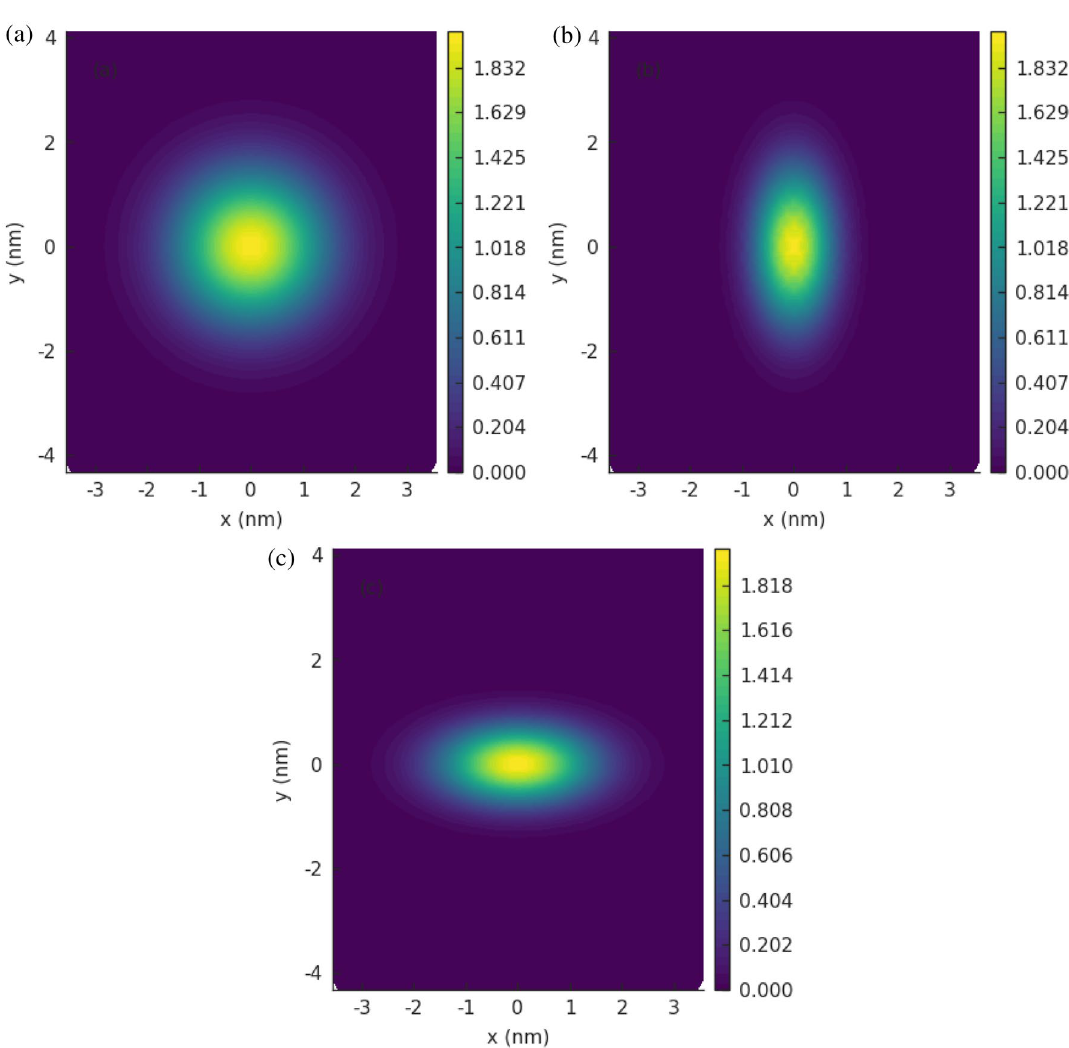
Figure 2. Rectangular GQDs (M=60, N=40) with elliptic Gaussian bumps in the center: ( a ) h G = 2 nm, σ x = 1 nm, σ y = 1 nm ; ( b ) h